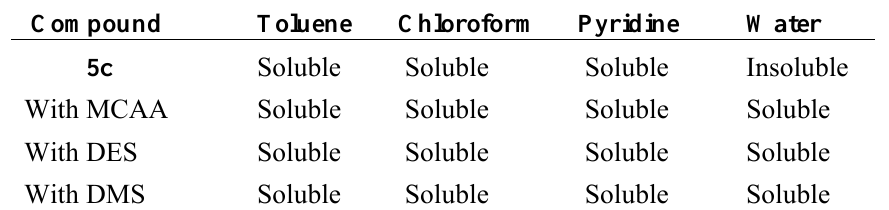
Table 4. Solubilities of 5c and quaternized compounds with MCAA, DES and DMS. Compound Toluene Chloroform Pyridine Water 5c Soluble Soluble Soluble Insoluble With MCAA Soluble Soluble Soluble Soluble With DES Soluble Soluble Soluble Soluble With DMS Soluble Soluble Soluble